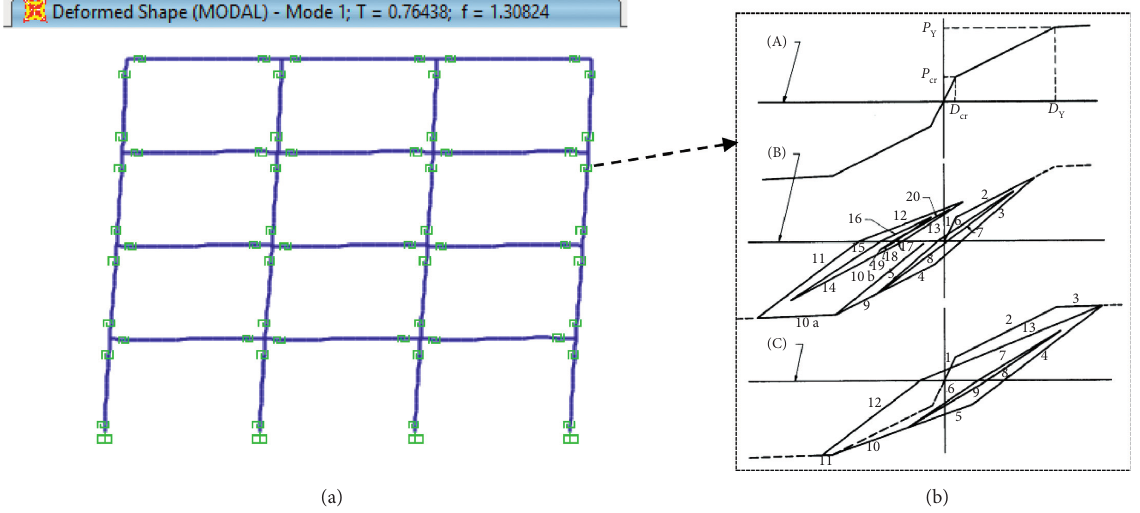
Figure 3: Modelling for inelastic analyses. (a) Modelling. (b) Hysteretic behaviour